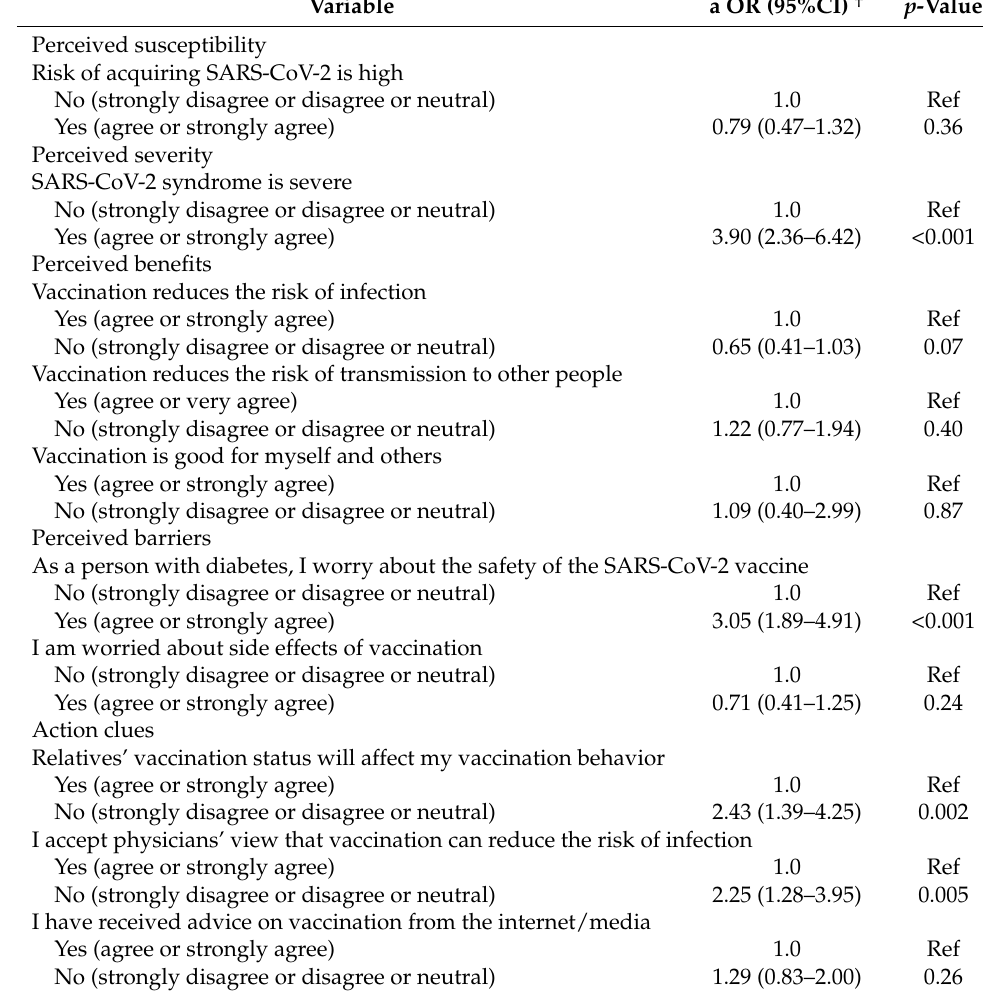
Table 4. Multivariate model of the factors associated with diabetes patients’ hesitation to receive the SARS-CoV-2